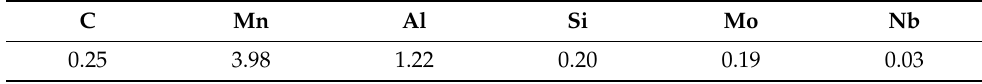
Table 1. Chemical Compositions of the Investigated Steel